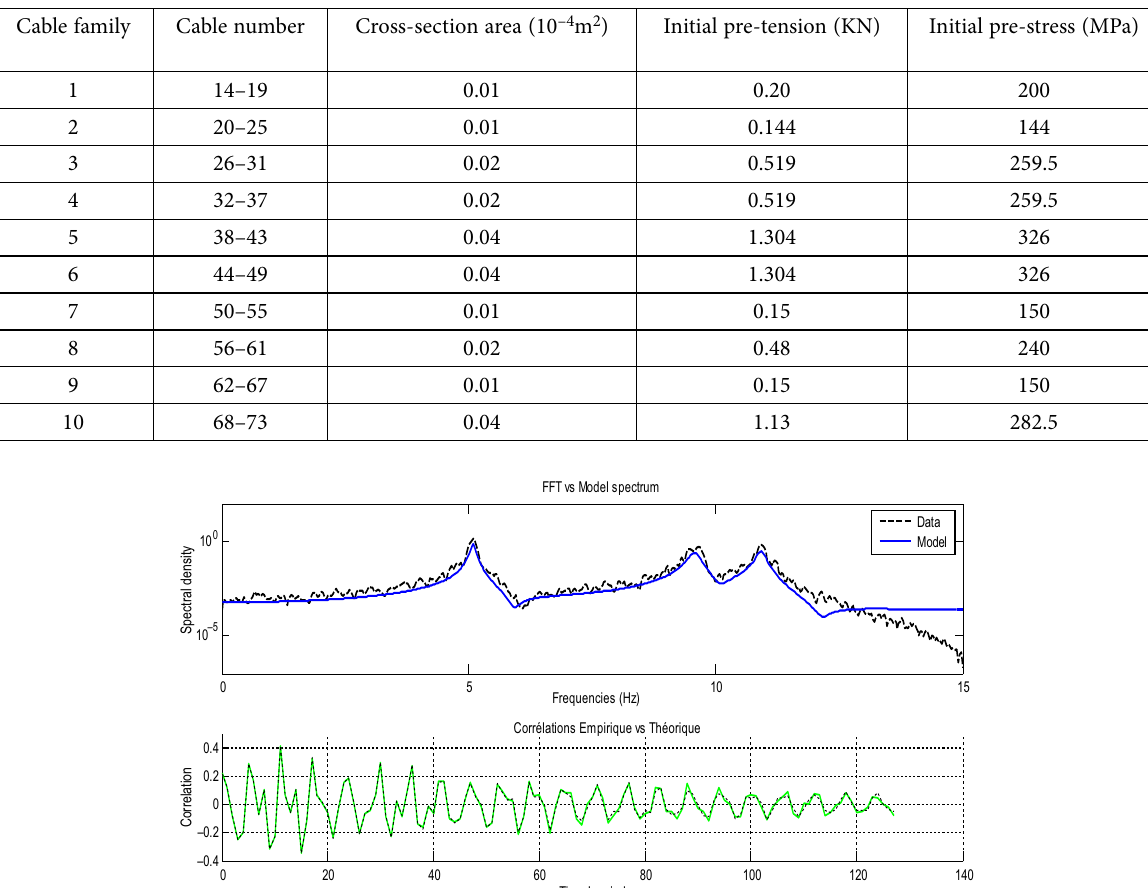
Table 6 . Cross-section area and initial pre-tension of different cable families of the Geiger dome